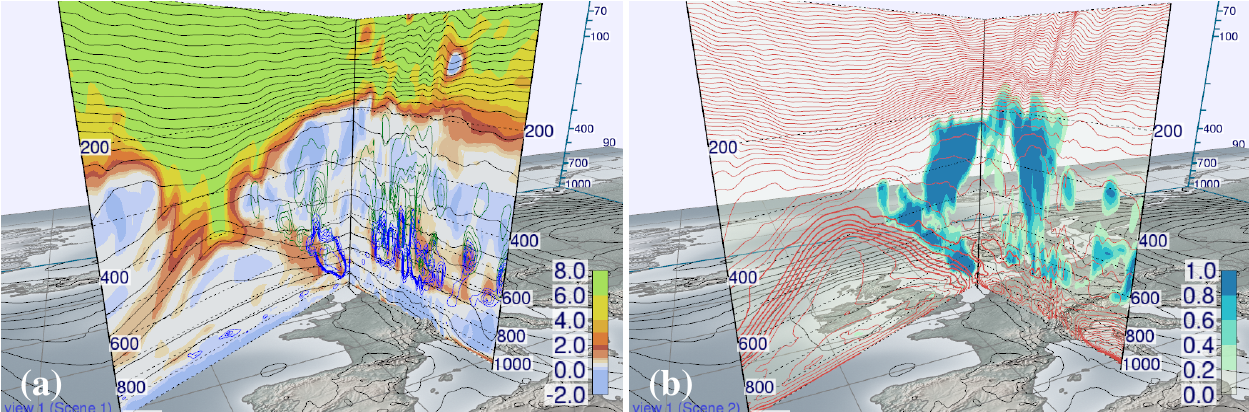
Figure 17. (a) Vertical section of potential vorticity (colour coding in PVU; red colours in the left plot mark the 2 PVU surface and thus the dynamic tropopause), potential temperature (grey contour lines), liquid and ice water content (blue and green contour lines). (b) Vertical section of cloud cover fraction (colour coding) and equivalent potential temperature (red contour lines). Black surface contour lines in both